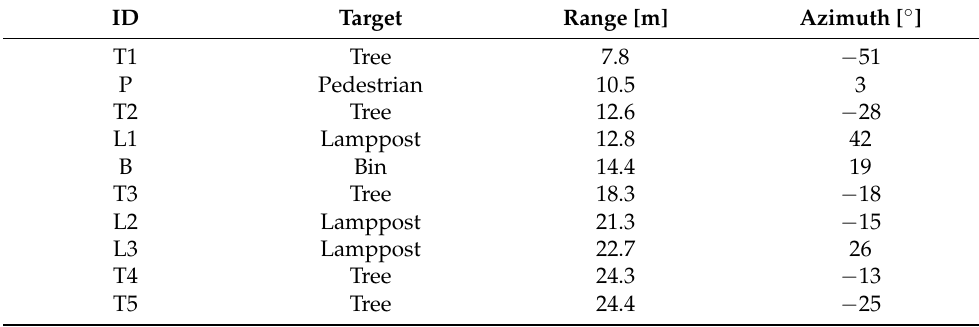
Table 2. Position (range and azimuth) of the detected